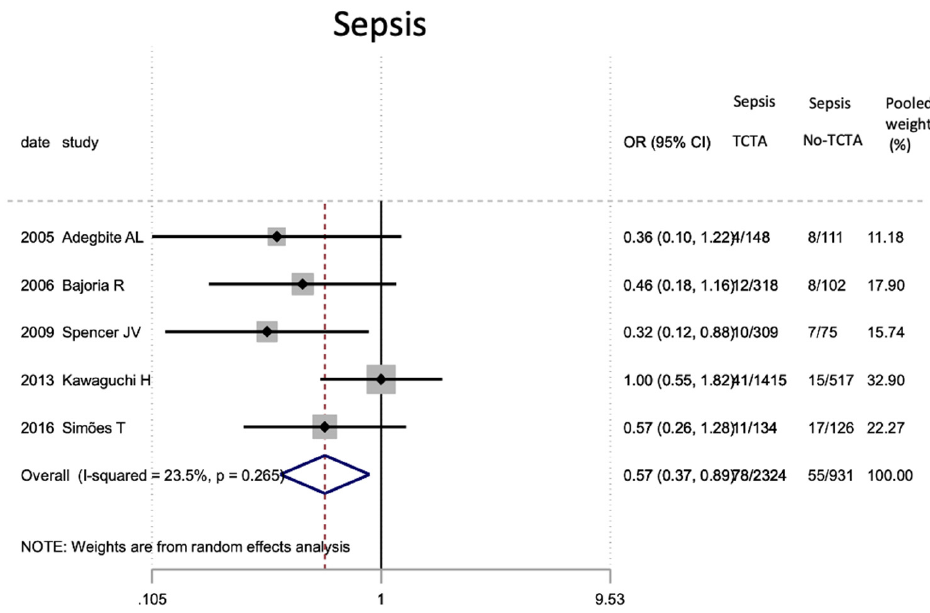
Figure 10. Results of the meta-analysis on the effect of chorionicity (TCTA vs no TCTA) on the development of neonatal sepsis; TCTA: trichorial-triamniotic, non-TCTA: non-trichorial-triamniotic. OR = odds ratio, CI = confidence interval.